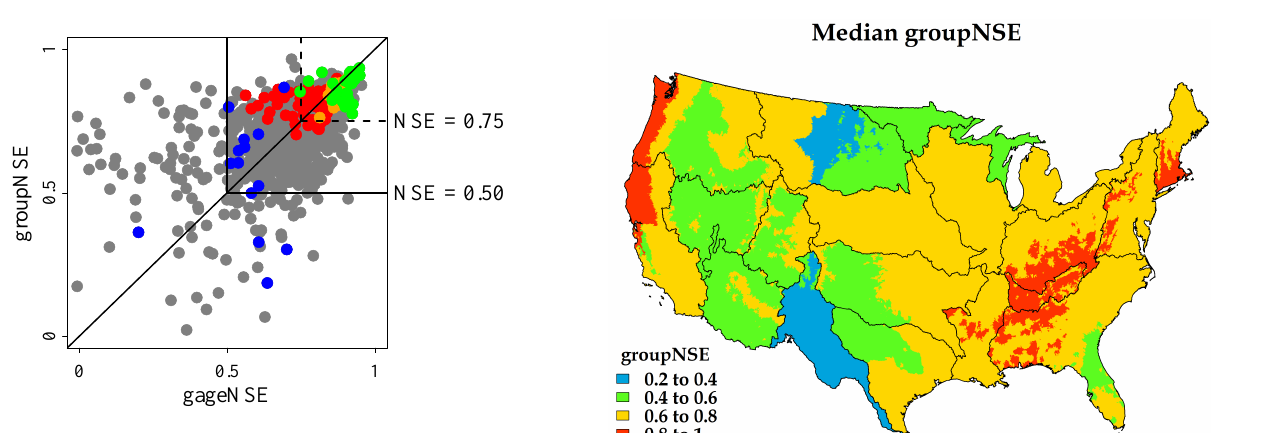
Figure 13. Nash–Sutcliffe efficiency from individual (gageNSE) and grouped (groupNSE) calibration. Calibration regions in New England (67 streamgages, red); Tennessee River (21 streamgages, orange); Platte Headwaters (15 streamgages, blue); and Pacific Northwest (33 streamgages, green) are highlighted (see Fig. 9b for location).